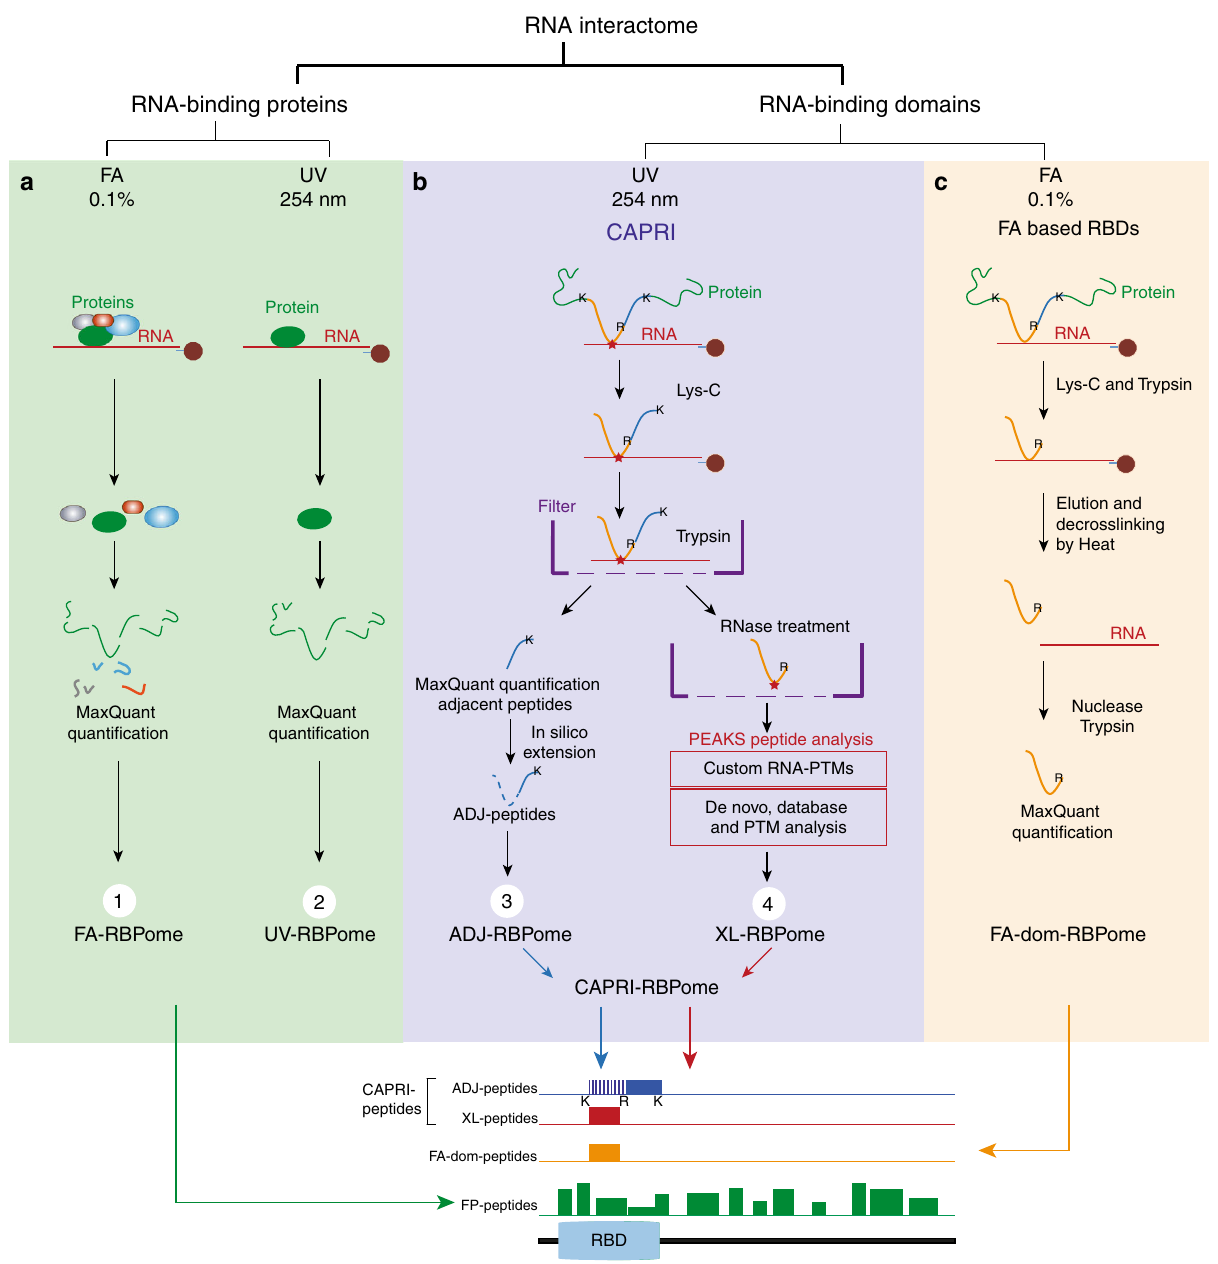
Fig. 1 Characterisation of RNA – protein complexes, RBPs and RBDs. We characterised the Drosophila RBPome at four levels of resolution. a (green box) On the fi rst two levels of resolution we focus on comprehensive identi fi cation of RBPs and RNA-associated protein complexes in Drosophila cells. First we used FA crosslinking to compile a dataset containing both direct and indirect RNA binders (FA-RBPome (1)). At the next level we used UV crosslinking to generate a dataset composed of direct RNA binders (UV-RBPome (2)). Both FA- and UV-RBPome datasets exhibit peptide coverage across the entire length of RBPs, which is illustrated by the green FP-peptides in the schematic in the lower panel. b (blue box) The next two levels of resolution focused on discovery of RNA – protein contact sites. We devised a new approach, termed CAPRI, which integrates two analysis pipelines to facilitate large-scale identi fi cation of RBDs. Brie fl y, UV-crosslinked RBPs are isolated using oligo-dT beads and digested with endoprotease Lys-C to release non-crosslinked peptides. The RNA-peptide moieties are eluted from the beads, transferred to a 30 kD fi lter and washed with 8 M urea to remove nonspeci fi c background peptides. The crosslinked peptides are further digested with trypsin (cutting C-terminal to K/R) to release the adjacent peptides (coloured blue) as fl owthrough. The RNA-peptide conjugates (orange-red) retained on the fi lter were released after degrading the RNA using a cocktail of nucleases. The MS/ MS data from all crosslinked replicates are submitted to PEAKS for a combined search with custom de fi ned monoisotopic masses of RNA adducts to identify XL-peptides. The non-heterconjugate peptides from all MS/MS data are analysed by MaxQuant. The statistically enriched peptides in the UV irradiated samples (adjacent-peptides) are reconstructed in silico to the original endoproteinase Lys-C-digested full peptide sequence (ADJ-peptides: blue). The ADJ-RBPome (3) and XL-RBPome (4) together give the CAPRI-RBPome. c (orange box) The FA-dom-RBPome provides complementary data on RBDs using FA as a crosslinker. Brie fl y, 0.1% formaldehyde-crosslinked RBPs are captured using oligo-dT beads and are further digested using Lys-C and trypsin. Following elution the RNA-peptide crosslinks are reversed by heating and later the nucleic acids are degraded by nucleases. The peptides are cleaned-up using SP3 puri fi cation and analysed using LC/MS NATURE COMMUNICATIONS| (2019) 10:2682